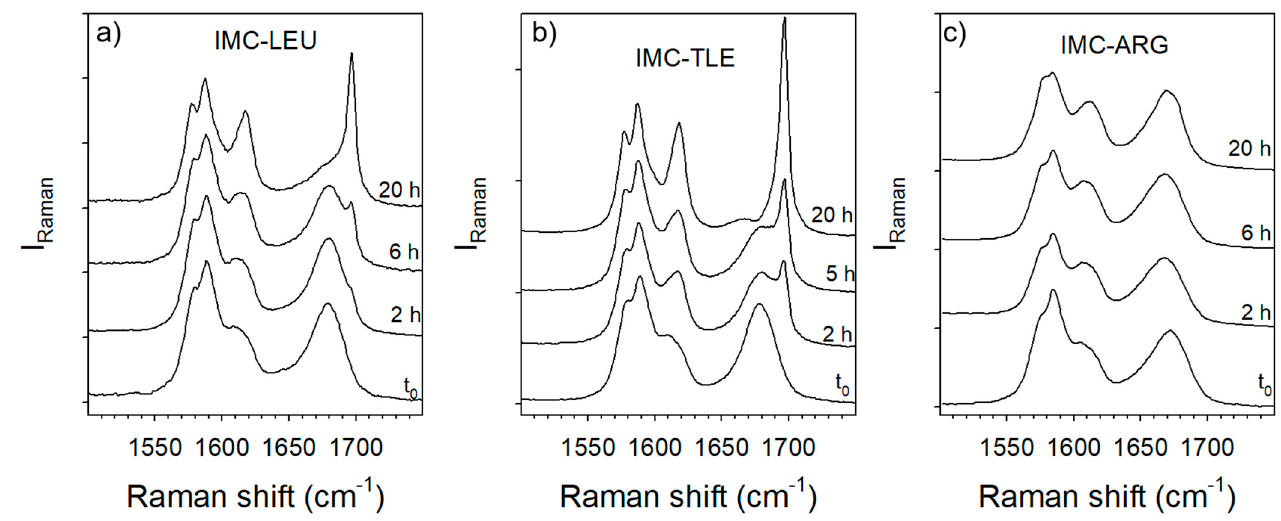
Figure 10 . Time dependence of the C=O stretching spectra of the co-amorphous blends exposed to 98% RH: ( a ) IMC–LEU; ( b ) IMC–TLE; ( c ) IMC–ARG .